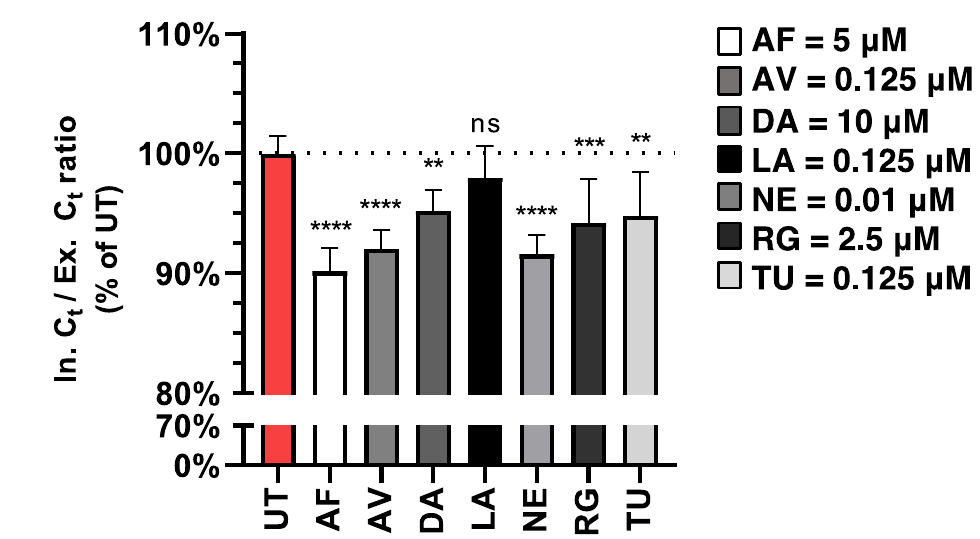
Figure 5. Treatments with different SMKIs limit IAV egress. A549 cells were infected at MOI = 5 in the presence of SMKIs [1 × ] max for 24 h, at which point viral RNA in the supernatant and cells was quantified by qPCR. All values were normalized to an internal control and GAPDH. The ratios of intracellular (In) Ct to extracellular (Ex) Ct values were calculated and are shown as the percentage of untreated infected cells. All measurements were taken from three independent experiments ( n = 7). Error bars indicate ± standard deviation (SD). **, p < 0.01; ***, p < 0.001; ****, p < 0.0001; ns, not significant ( p > 0.05). p -values were determined by Welch t -tests compared to untreated